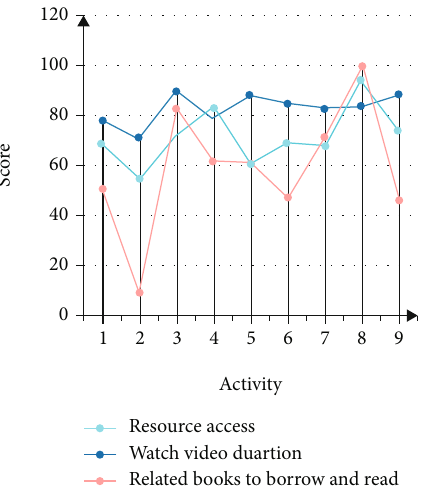
Figure 4: Visualization results of students ’ learning attitude and self-directed learning activity initiative.